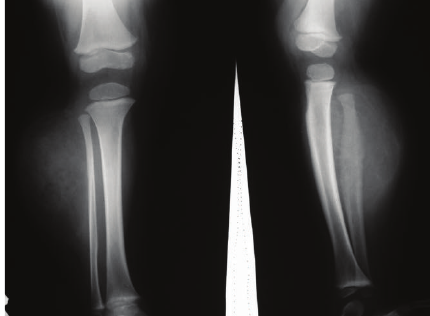
Figure 7: Plain radiograph of Case 2 showed a soft tissue mass with a more diffuse fatty-like radiolucent component. Although bowing deformitywasnotseen,periostealthickeningofthefibulawasnicely depicted.